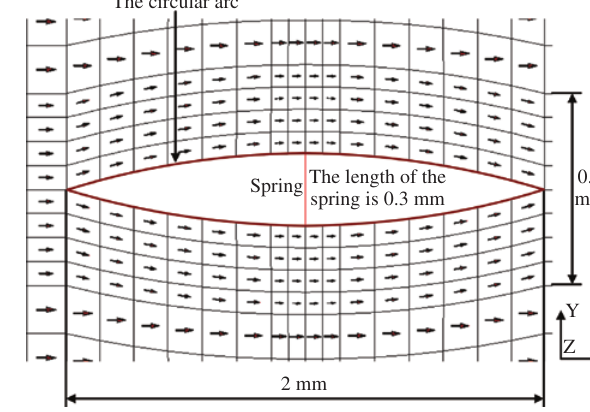
The circular arc